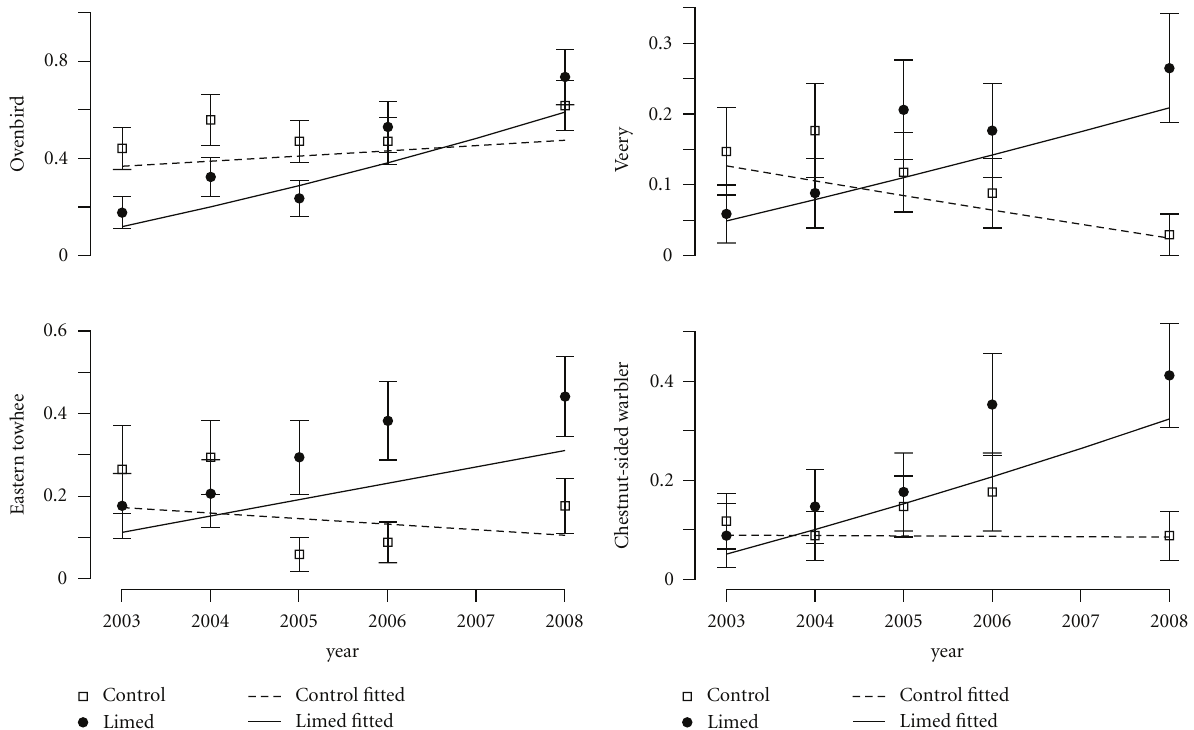
Figure 5: Mean abundance (count per point) of Ovenbird, Veery, Eastern Towhee, and Chestnut-sided Warbler with SE bars and model lines on lime-treated and control sites. Lime treatment was applied between 2003 and 2004 in central